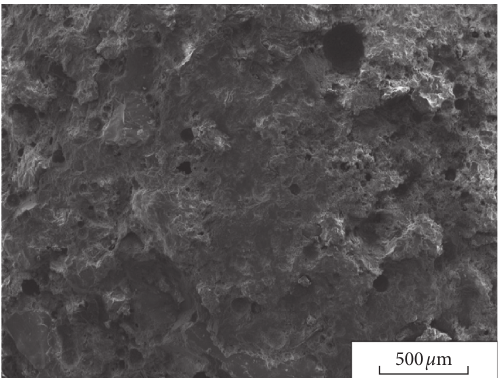
Figure 15: Microstructure of the PVA fiber in concrete.